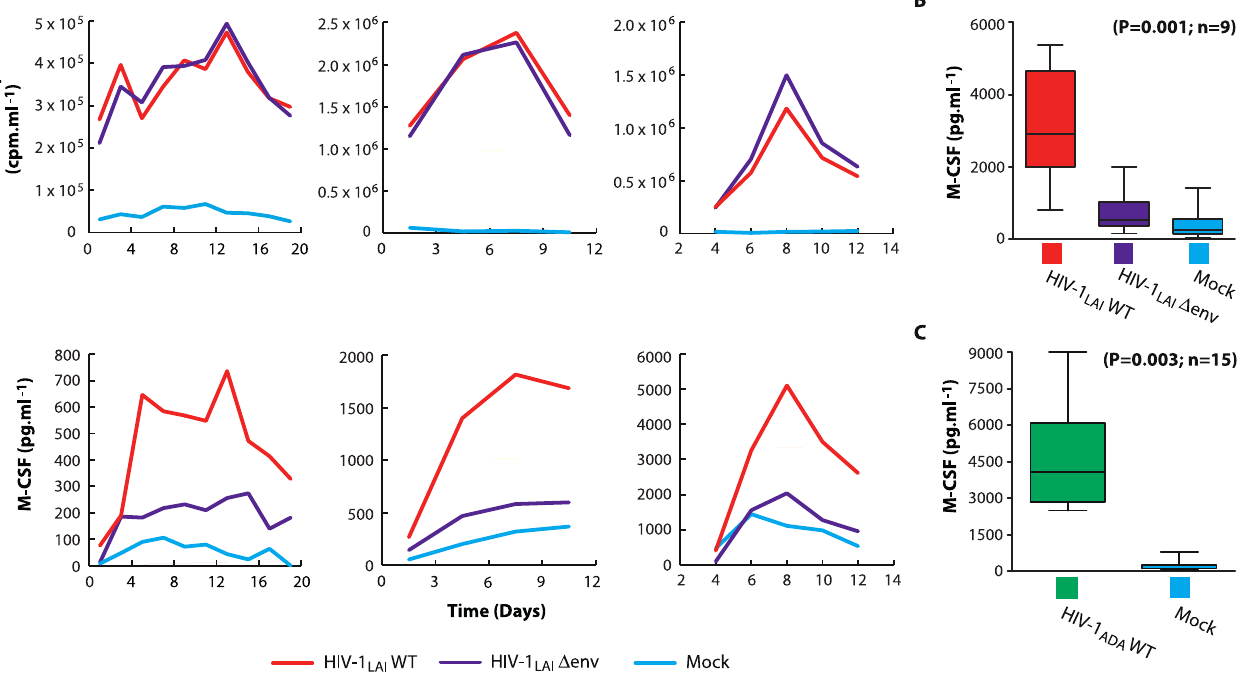
Figure 1. HIV-1 Envelope-Dependent M-CSF Induction by Infected Macrophages (A) Levels of virus (upper panels) and M-CSF (lower panels) production by macrophages following infection with VSV-envelope pseudotyped X4 HIV-1 variants (HIV-1 LAI ) containing intact (WT) or defective ( D env) HIV-1 envelope genes. Results obtained with macrophages from three independent donors are shown. (B) Statistical analysis of peak mean M-CSF release by pseudotyped X4-tropic HIV-1 LAI WT, HIV-1 LAI D env or mock-infected macrophages (ANOVA; error bars, SEM), and (C) by macrophages infected with R5-tropic HIV-1 ADA WT or mock-infected ( t -test; error bars,